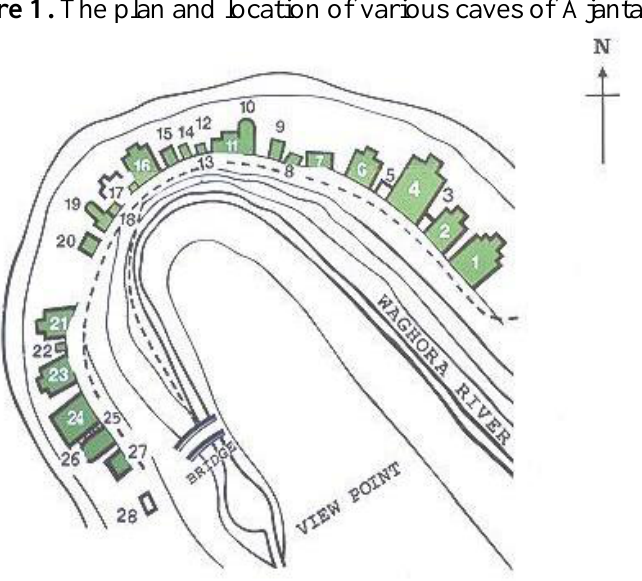
Figure 1. The plan and location of various caves of